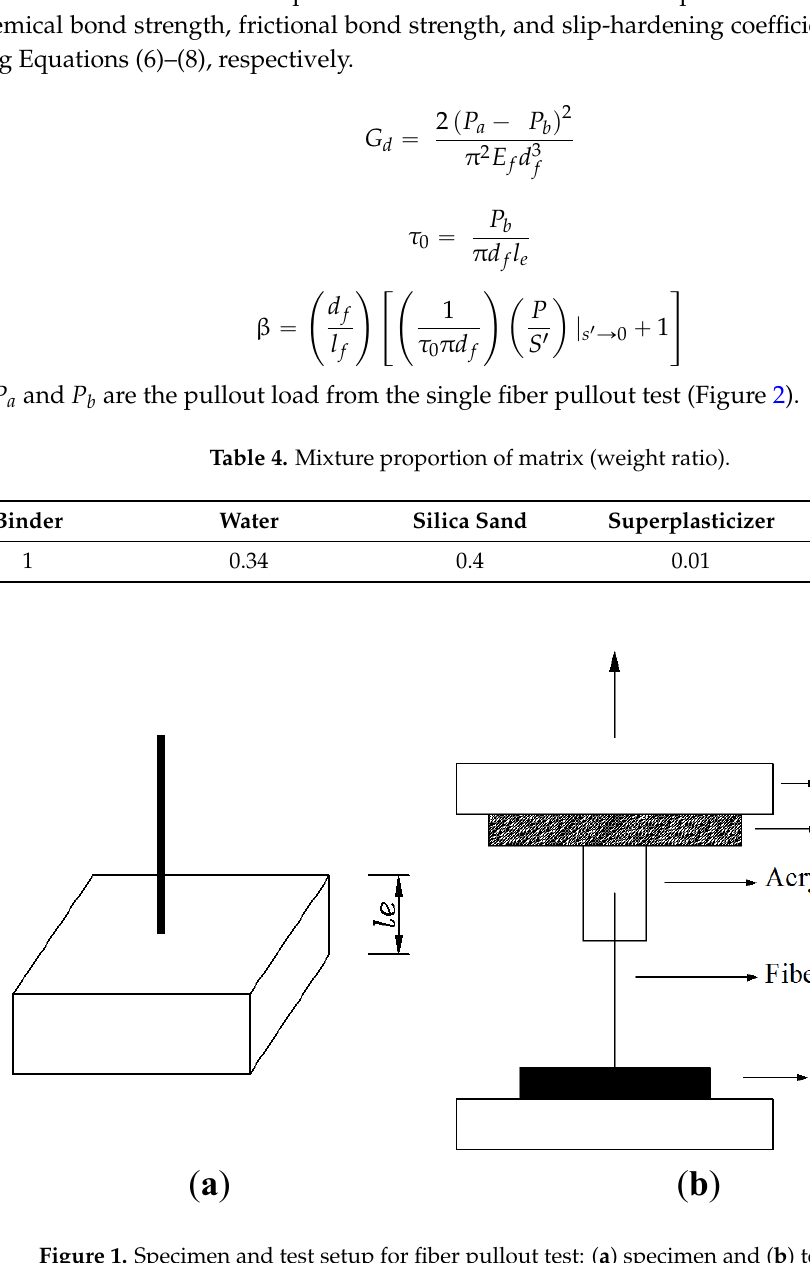
Figure 2. General profile of a single fiber pullout curve [17]. 3.3. Fiber Strength Test According to Fiber Orientation Fiber rupture behavior is dependent on the type of matrix. Therefore, fiber embedment in a matrix is necessary to reproduce fiber pull-and-rupture behavior in a certain composite. In this study, the test setup in Figure 3 was adopted to investigate the relative effect of fiber orientation on the fiber strength according to fiber types excluding the effect of the type of matrix. An aluminum jig was made and the one end of fiber was attached with glue at the jig and the other of fiber was attached to the acrylic plate. The fiber orientation was selected as 0°, 30°, 45° and 67.5°. A 5-N load cell was used to measure the fracture load of the fiber according to fiber orientation with a displacement rate of 0.1 mm/min. Based on the experimental results, the fiber strength reduction coefficient was determined by regression analysis.